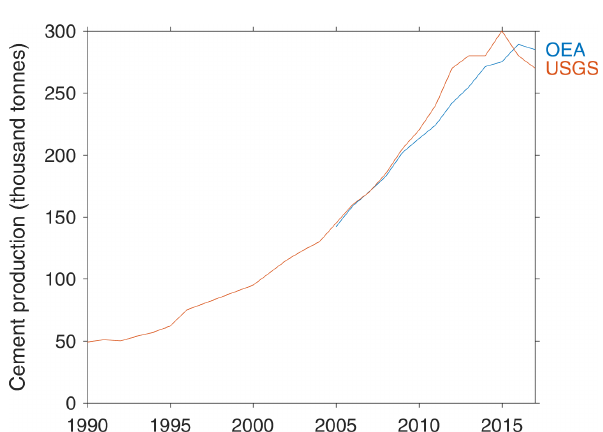
Figure C5. Estimates of clinker ratio in India from various sources.